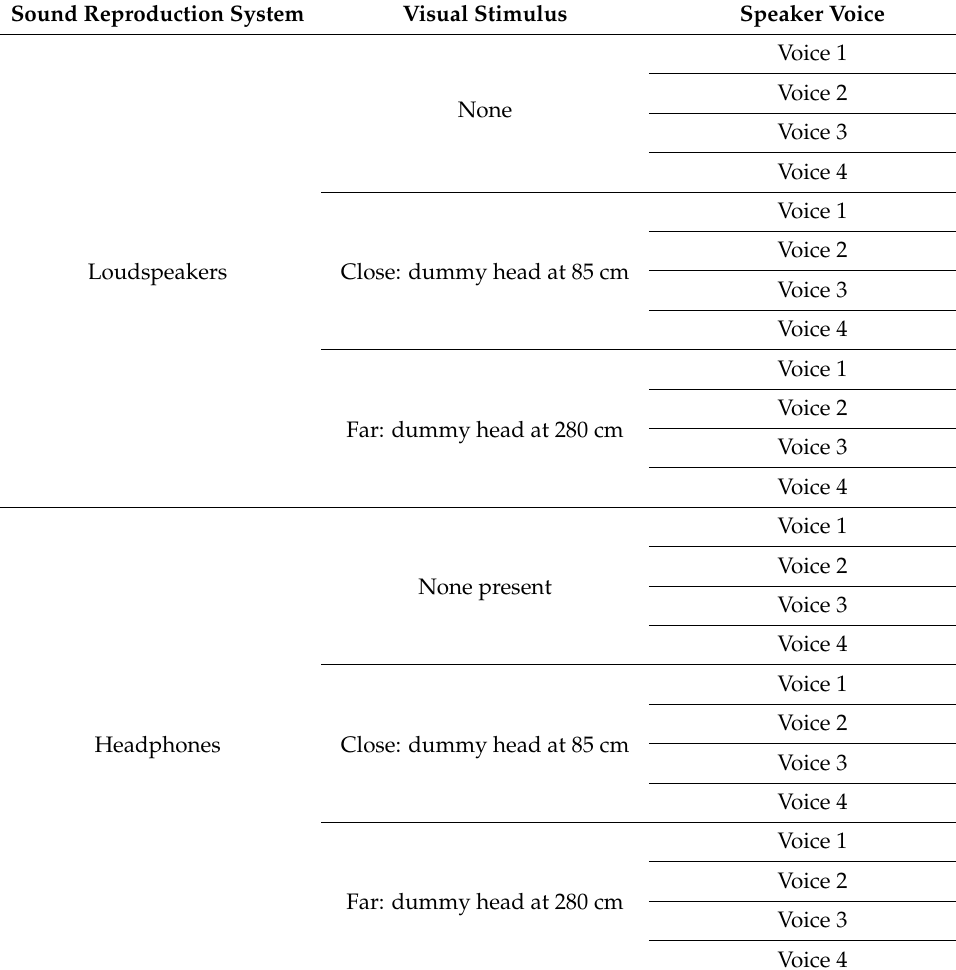
Table 1. The levels of the three factors investigated in the listening part of the experiment: Sound reproduction system (loudspeakers or headphones), visual stimulus (none present, dummy head close to the listener, dummy head far from the listener), and speaker voice (four different voices), yielding 24 different experimental conditions the subjects experienced during